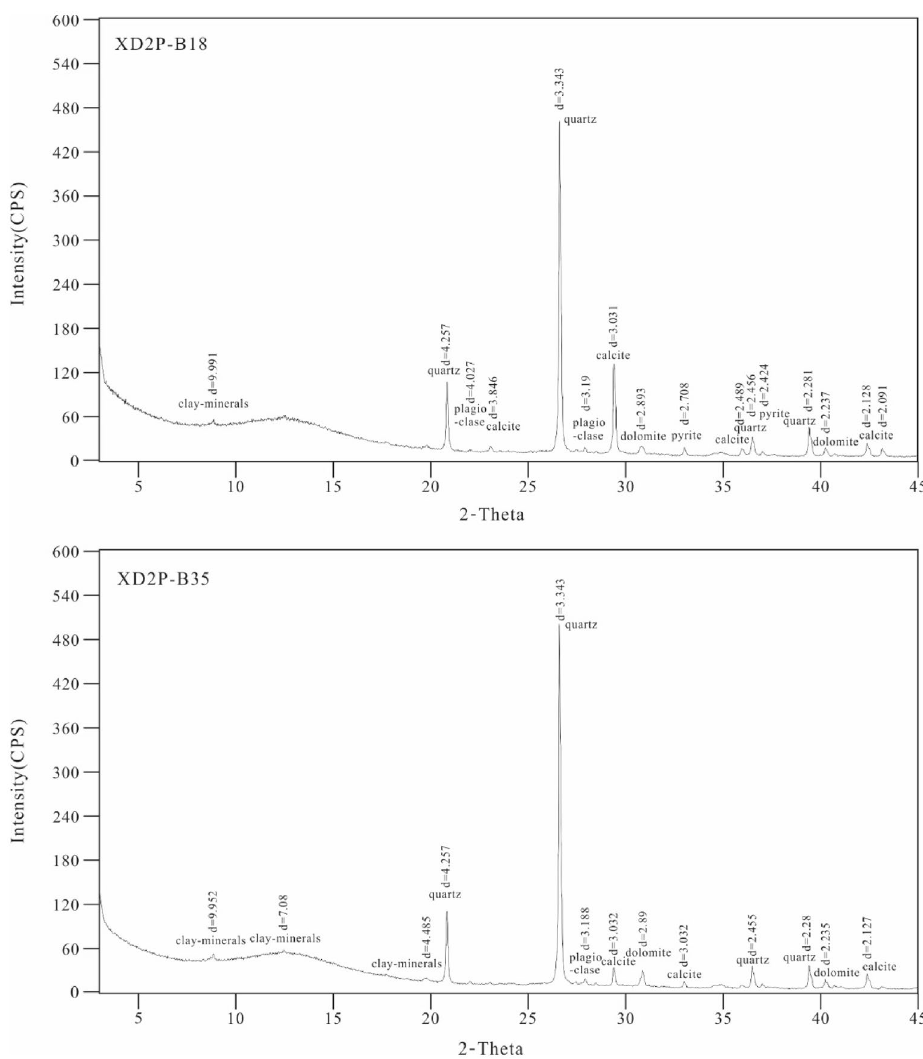
Figure 4. XRD patterns of studied samples XD2P-B18 and XD2P-B35 (the marks in the figure are eigenvalues and corresponding